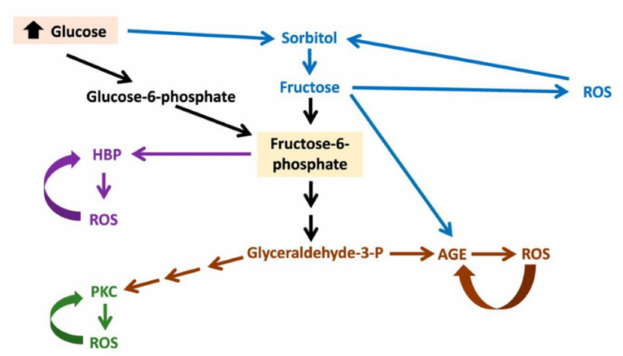
Figure 3. A model to demonstrate the metabolic vicious cycle whereby hyperglycemia-mediated stimulation of NOGPs fuels oxidative stress and further NOGP activation. The ROS produced by activation of the various NOGPs play a central role in fueling this vicious metabolic cycle. ROS produced by each pathway will further stimulate the respective NOGP as indicated, while also fueling the other NOGPs. The ROS produced will inhibit flux through the glycolytic pathway to further increase NOGP activation. In addition, higher ROS levels will deplete glutathione (GSH) and thus increase polyol pathway flux. Greater ROS availability will result in glucose autoxidation and lipid peroxidation that will generate increased AGEs. Increased ROS such as H2O2 can also directly cause activation of PKC. In addition, the polyol pathway plays a key role by activating other NOGPs. Here, it can generate fructose that can be further metabolized to produce AGEs and fructose-6-phosphate, which can lead to activation of the HBP, PKC, and AGEs. Mapanga, R.F., Essop MF. Am J Physiol Heart Circ Physiol 2016; 310: H153–H173 (Ref.